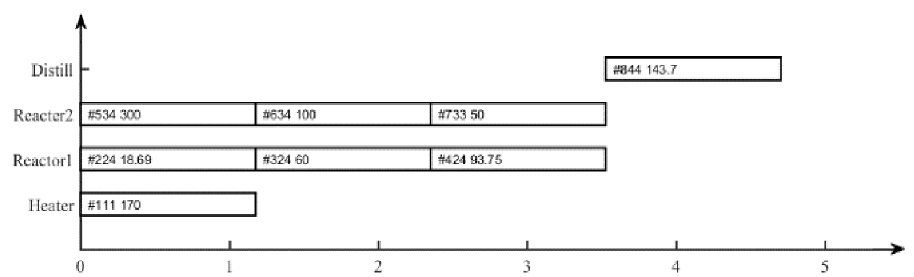
Fig. 9. Sequential scheduling Gantt